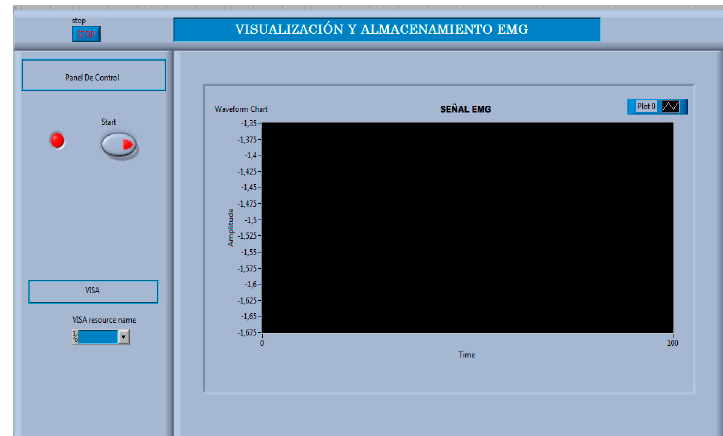
Figure 4. Control panel of the user interface.